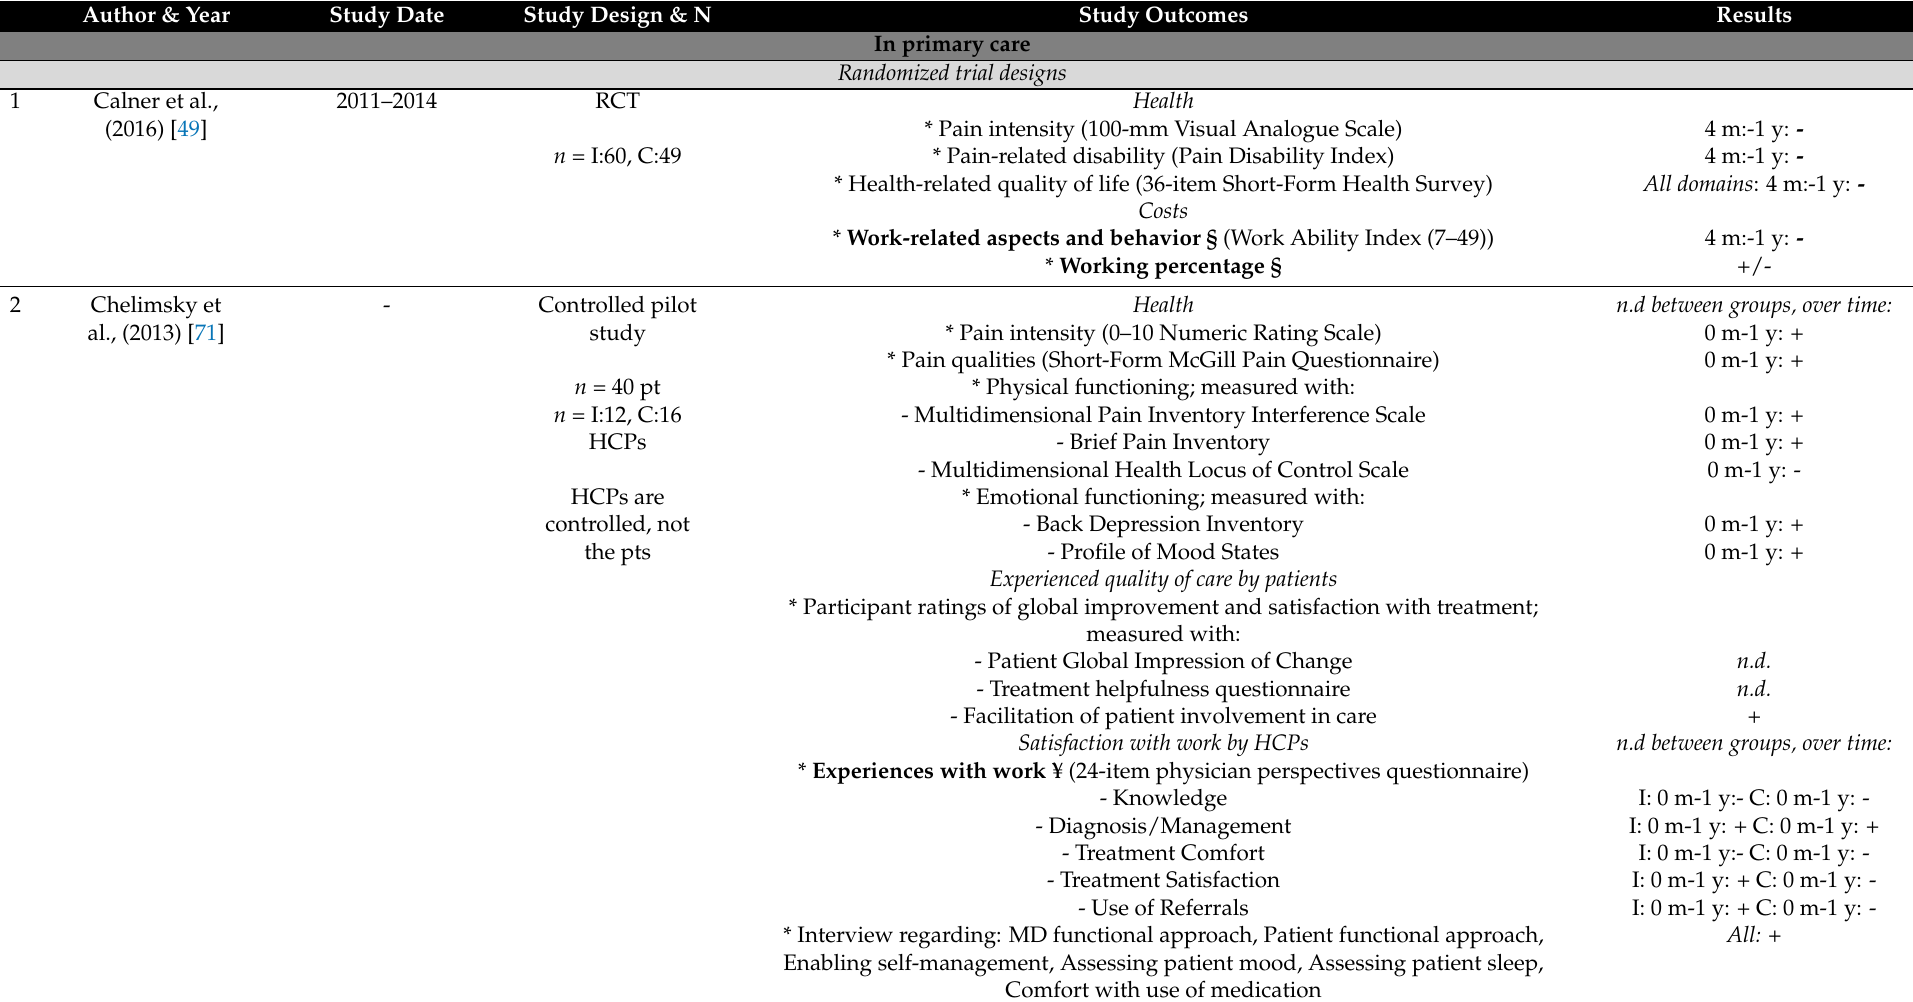
Table 3. Overview of study designs, study outcomes, and results based on the Quadruple